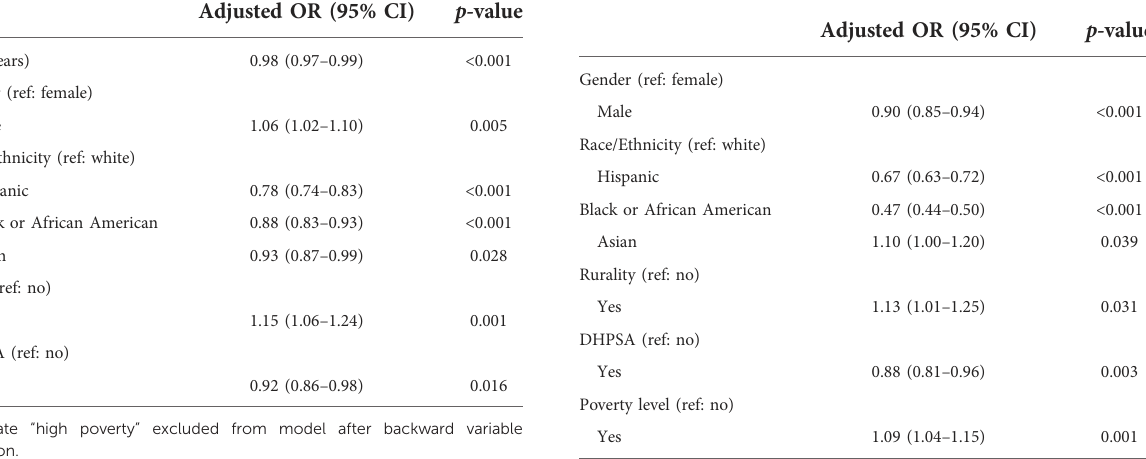
TABLE 2 Adjusted odds ratio estimates for the effect of demographic covariates on provision of more than one NSRCT from multivariate logistic regression analysis.